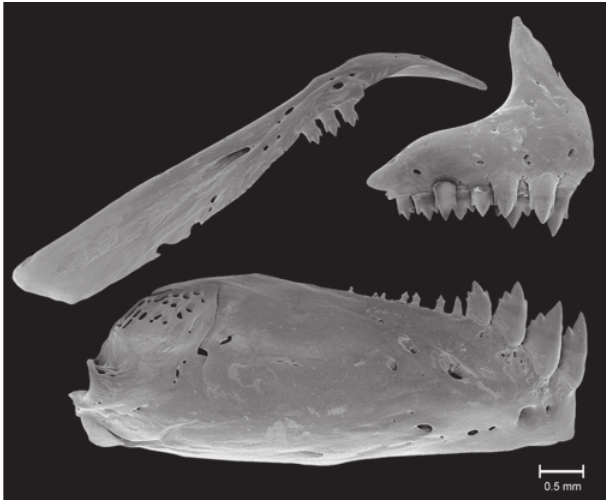
Fig. 3. Upper and lower jaws of Moenkhausia chlorophthalma , paratype, MZUSP 97092, 43.3 mm SL; lateral view, anterior to right, SEM